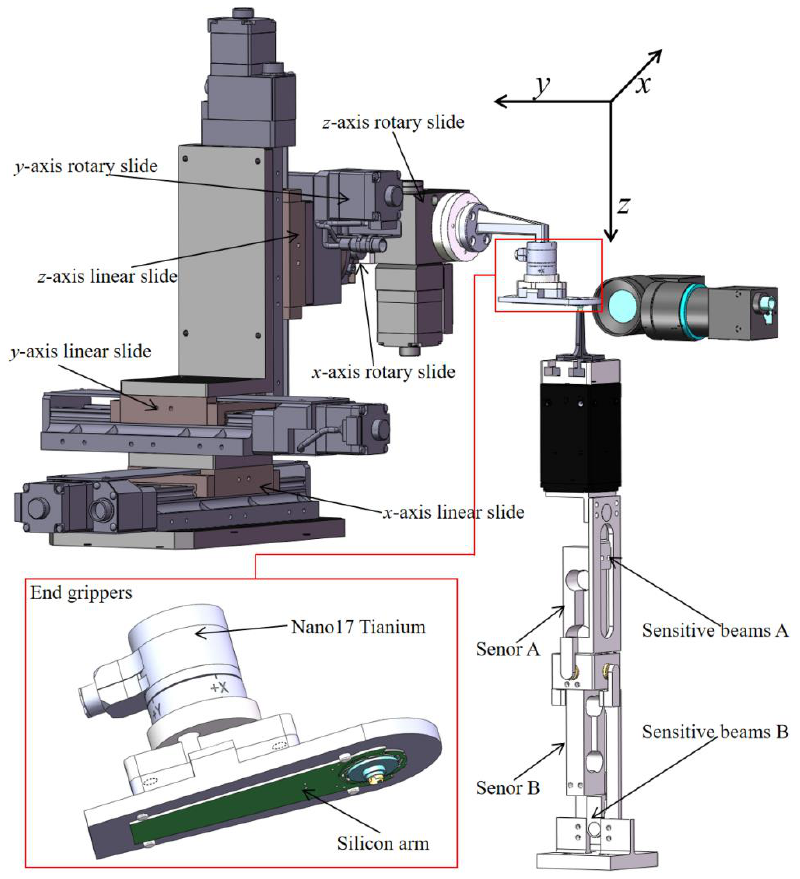
Figure 2. Structure of the flexible assembly system.